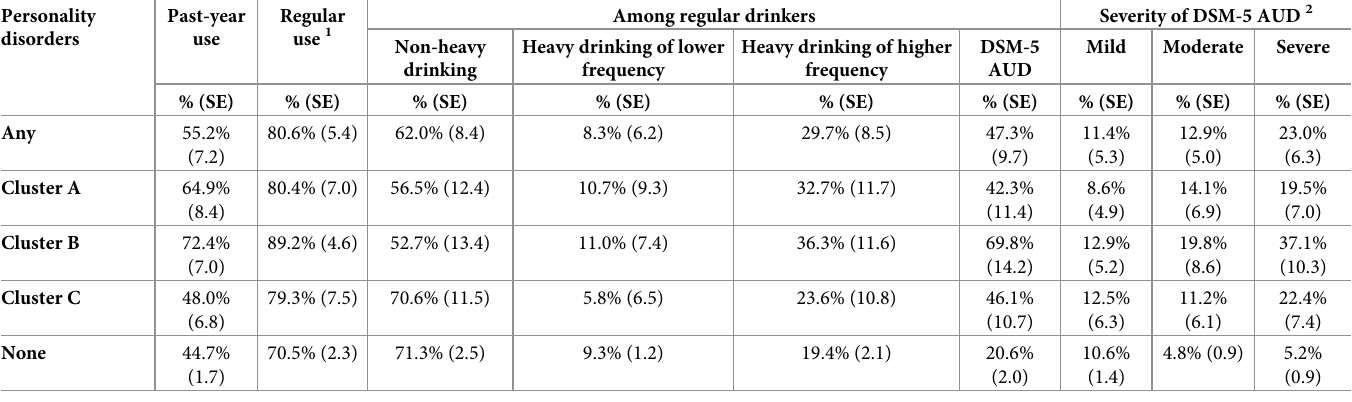
Table 2. Weighted conditional prevalence estimates of past-year alcohol use, drinking patterns and alcohol-use disorder among subjects with personality disorders in the S ã o Paulo Metropolitan Area, Brazil (N =